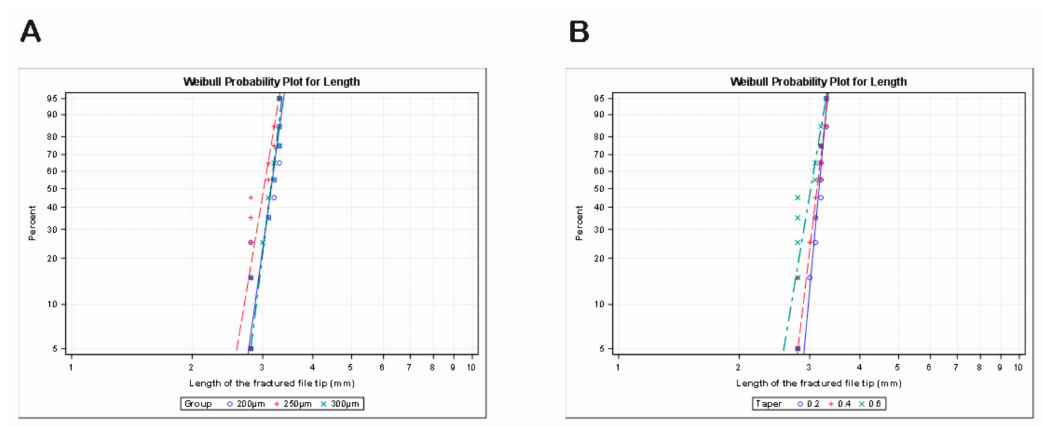
Figure 12. The Weibull probability plots of the length of fractured files regarding the ( A ) apical diameter and ( B ) taper study